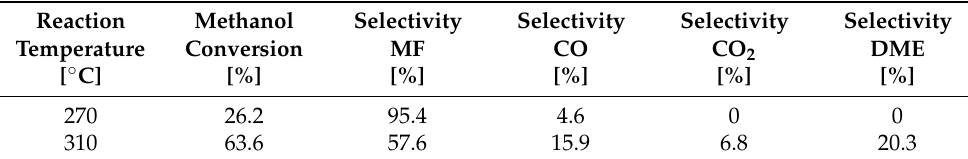
Table 3. Production of MF catalyzed by CuO/Al 2 O 3 (Cu:Al 1:2) [39].